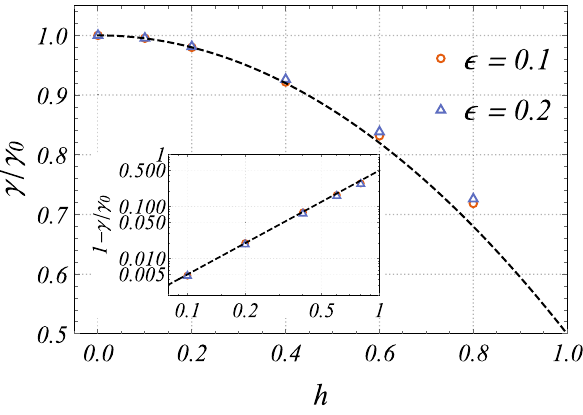
FIG. 7. Scaling of the decay rate γ ¼ γ ð ϵ ; h Þ of the order parameter (cf. Fig. 6) as a function of the longitudinal kick component h for different fixed values of ϵ . Rates have been rescaled by γ 0 ¼ γ ð ϵ ; h ¼ 0 Þ . The dashed line is the result of the fit γ = γ 0 ¼ 1 − ch 2 for the relative correction, where c ≃ 1 = 2 . The inset shows the same data in the log-log scale. K ϵ V for ϵ ¼ 0 . 1 = 2 ;h J